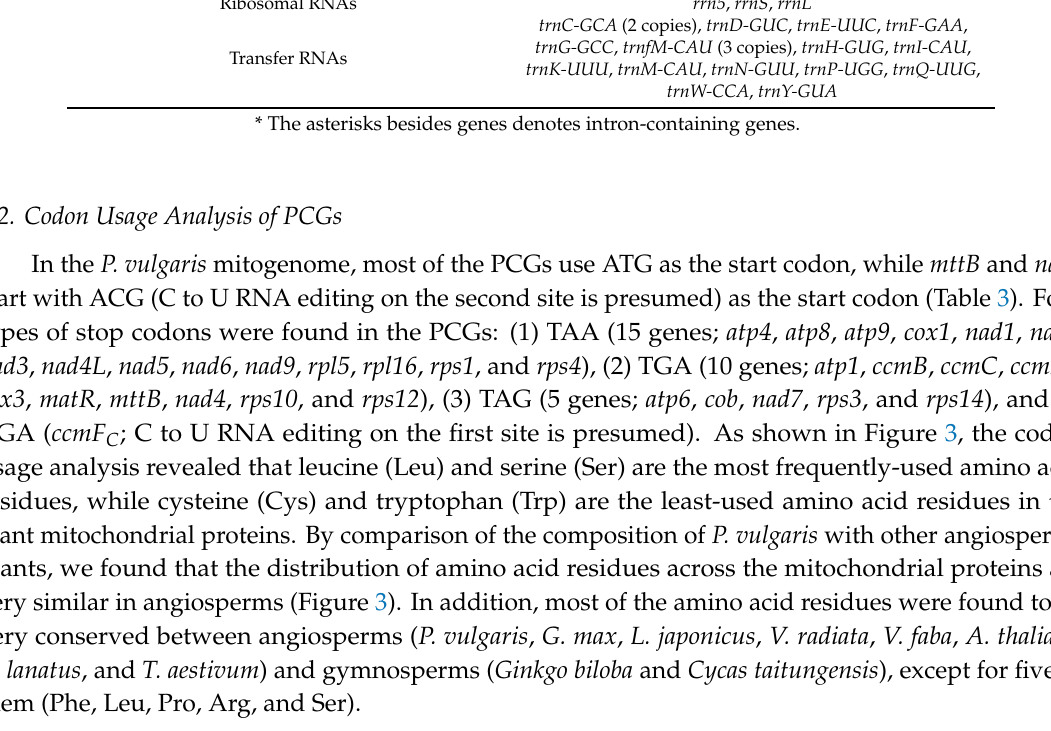
Table 3. Gene profile and organization of PCGs in P. vulgaris mitogenome.